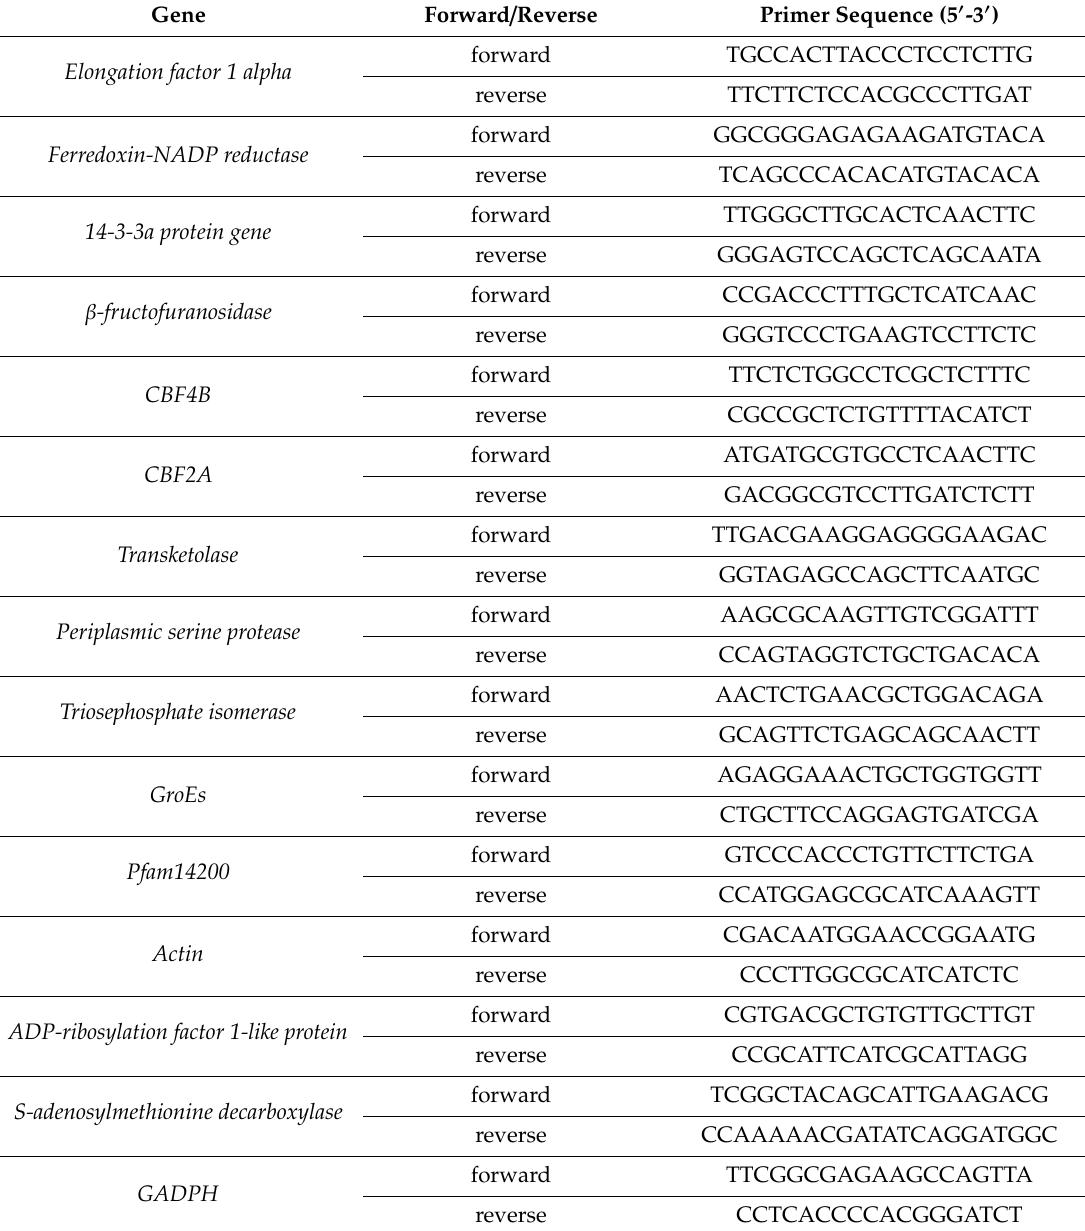
Table 2. Real-time RT-PCR primer